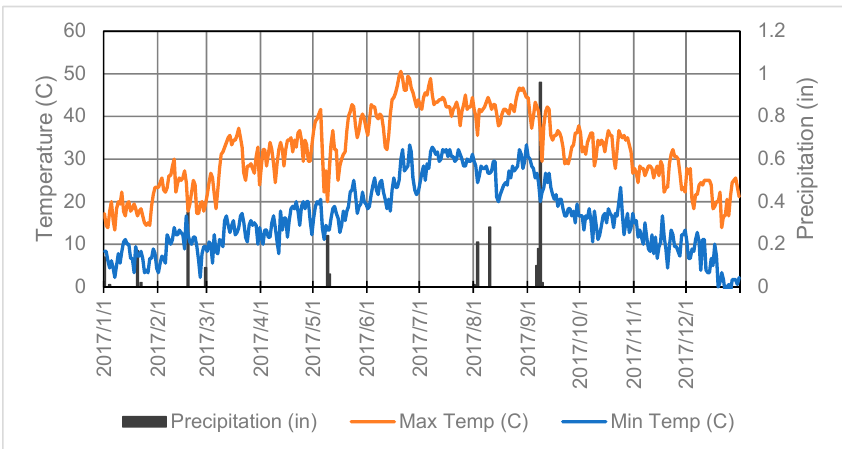
Figure 2. Climatology from the Ford Dry Lake SCAN station in 2017.